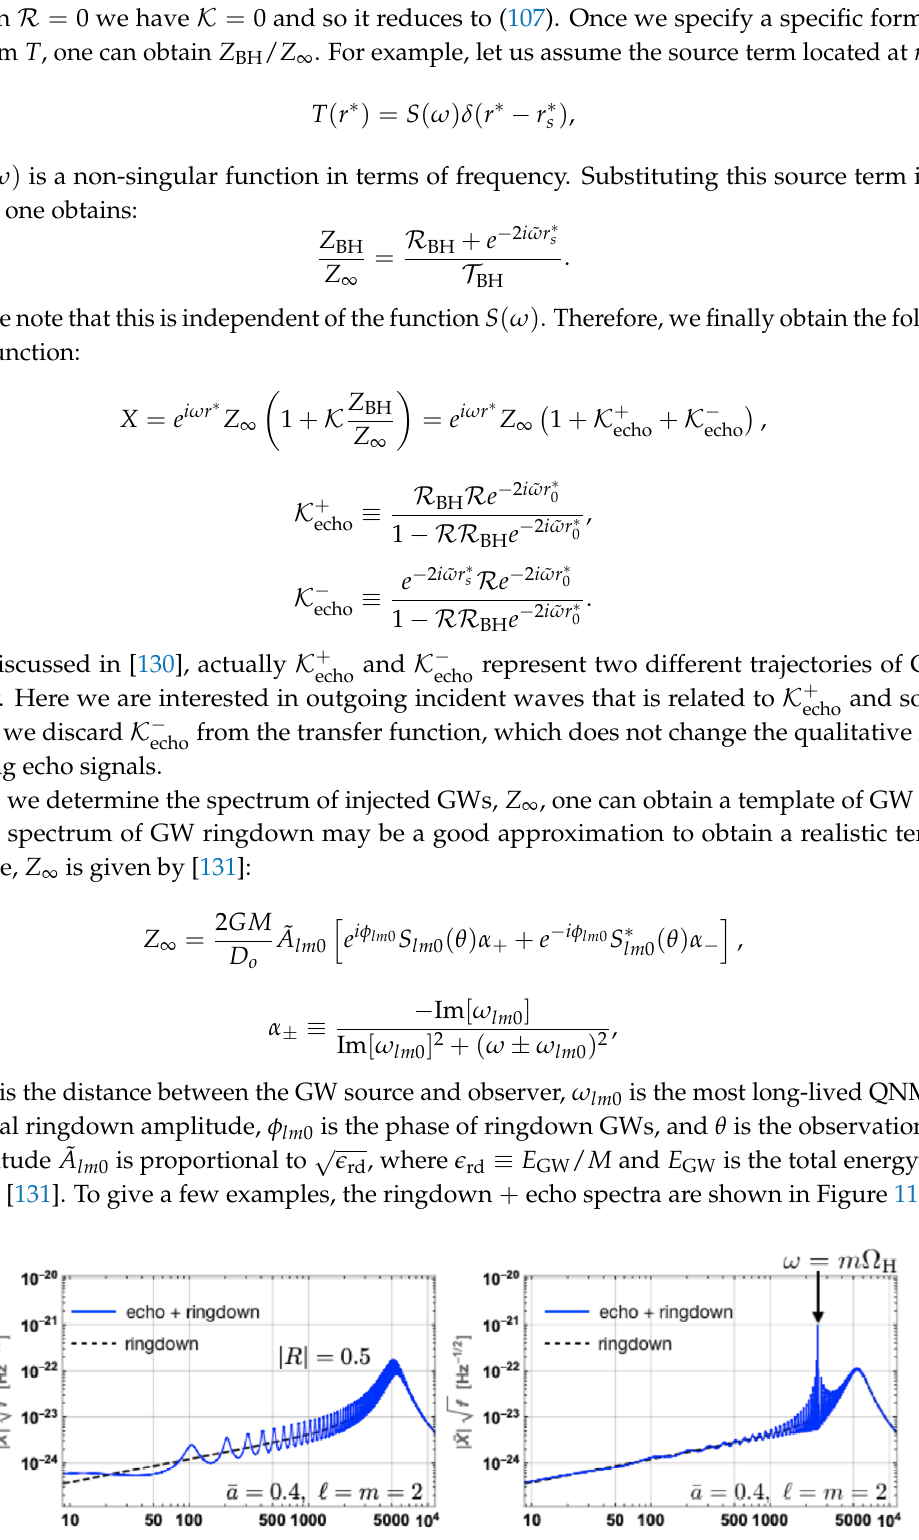
Figure 11. Spectra of echo + ringdown with ¯ a = 0.4, (cid:96) = m = 2, and M = 2.7 M Mpc, and θ = 90 ◦ . The left panel shows the spectrum in the constant reflectivity model with and the right panel shows the spectrum in the Boltzmann reflectivity model with ˜ γ =